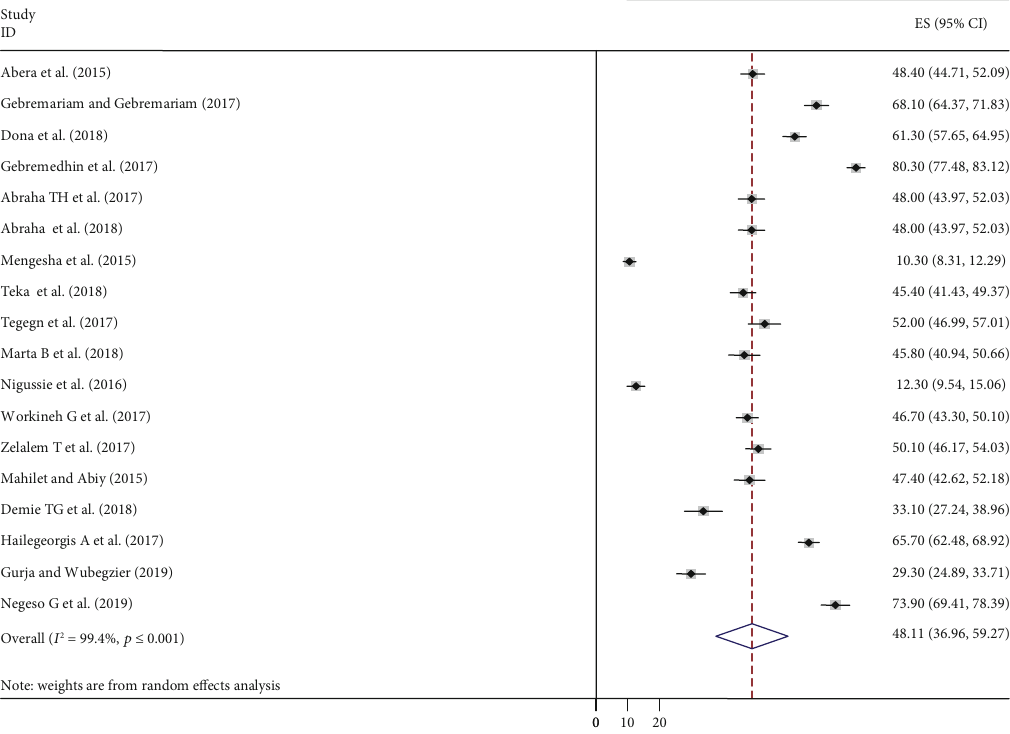
Figure 2: Forest plot of the pooled prevalence of postpartum contraceptive use in Ethiopia,